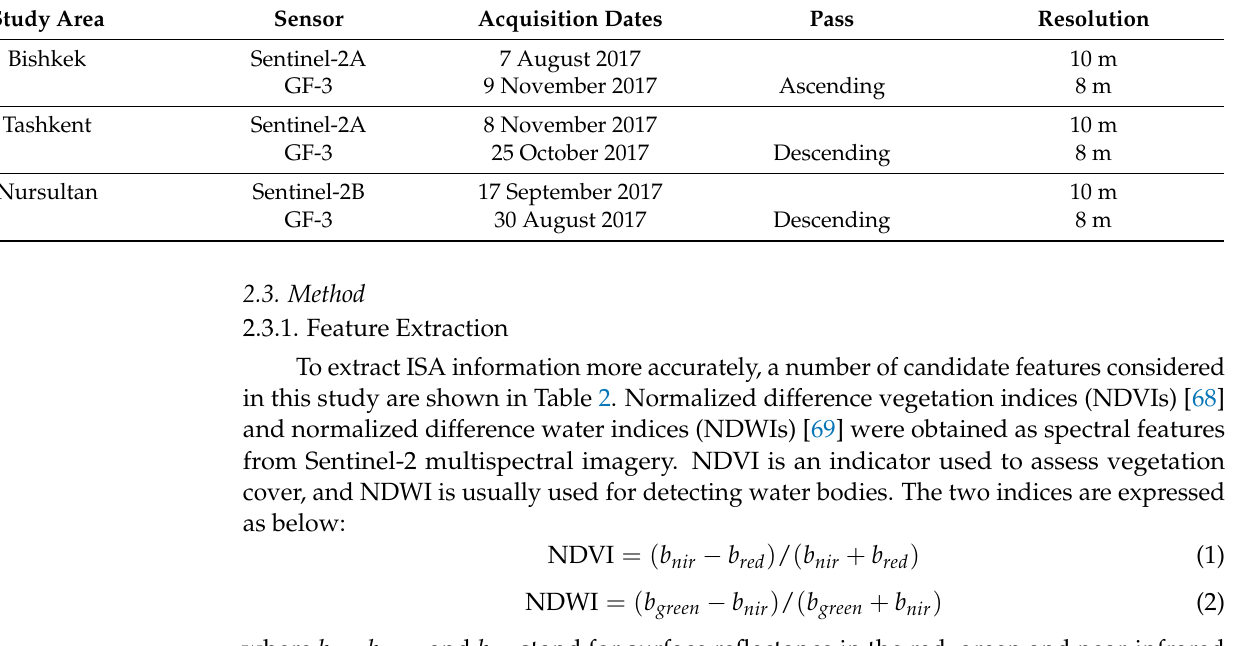
Table 1. Sentinel-2 and GF-3 data for the study areas used for ISA extraction.